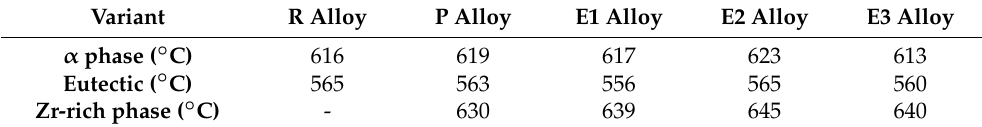
Table 3. Temperatures of structural components formation in R, P, and experimental melts E1–E3.